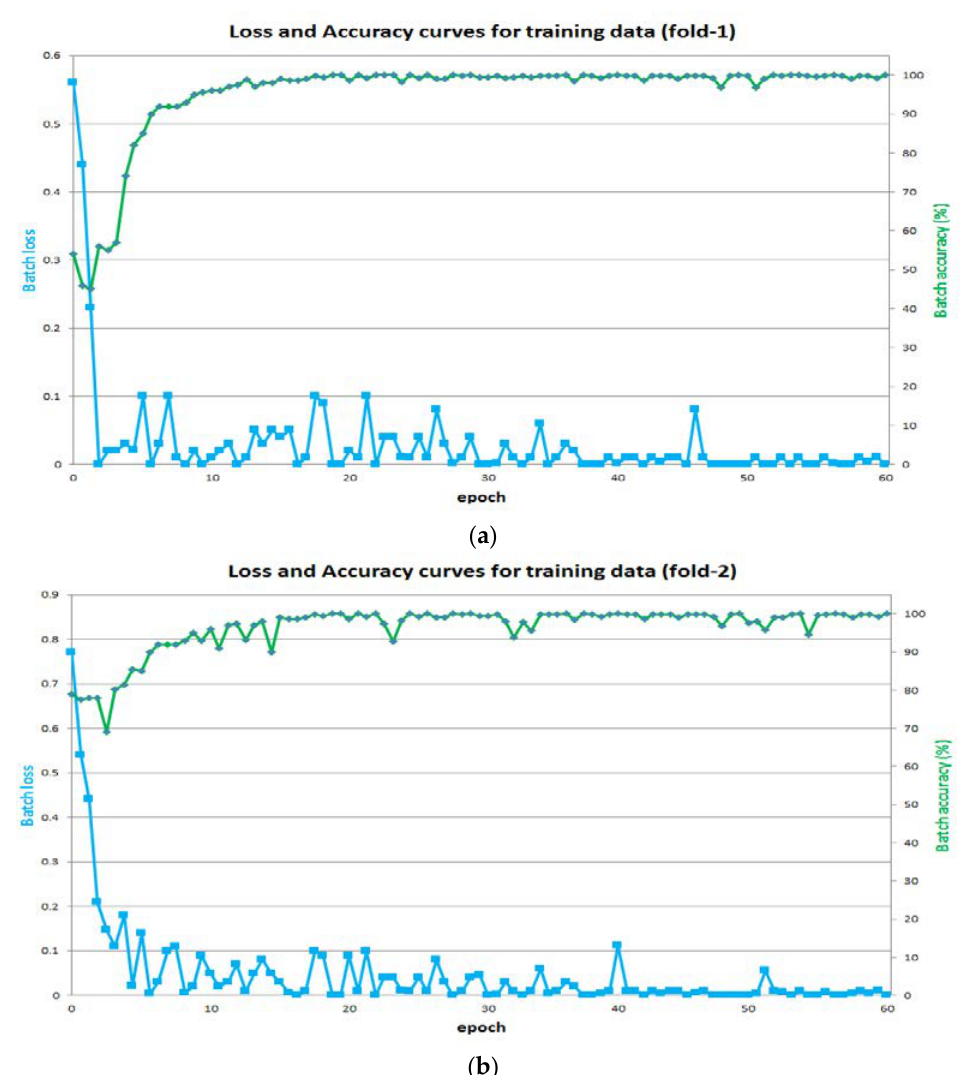
Figure 7. Training accuracy and loss curves from ( a ) 1st-fold cross-validation and ( b ) 2nd-fold cross-validation.